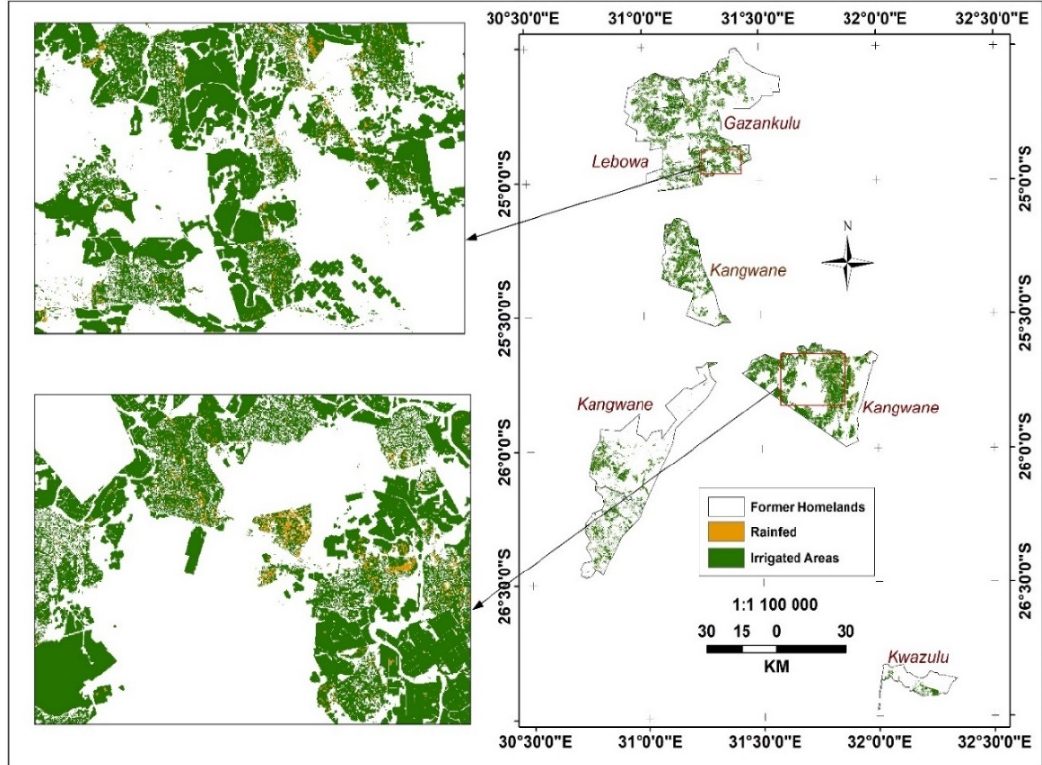
Figure 7. Irrigated and rainfed areas in former homelands in winter 2020.